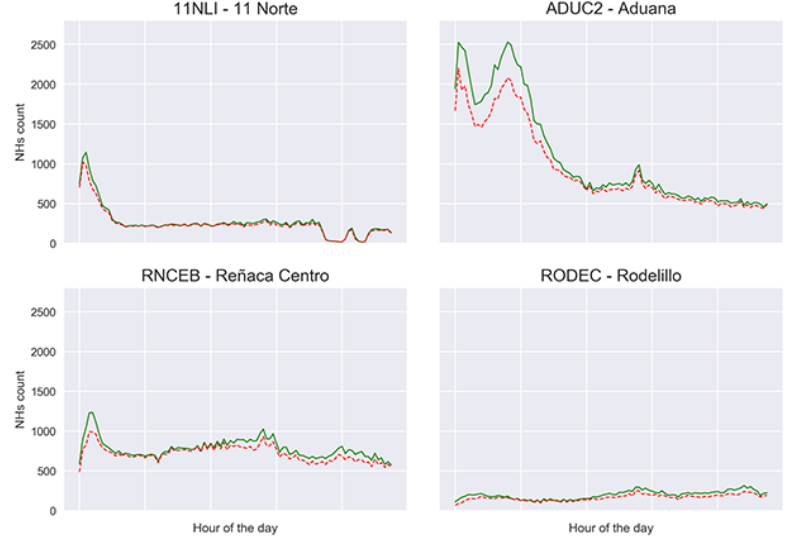
Figure 12. New Years activities in Great Valparaíso. We see 4 different locations using real (green) and synthetic (red) data. 11 NLI is a commercial area, ADUC 2 is the epicenter of fireworks, RNCEB is a popular beach, and RODEC is a residential